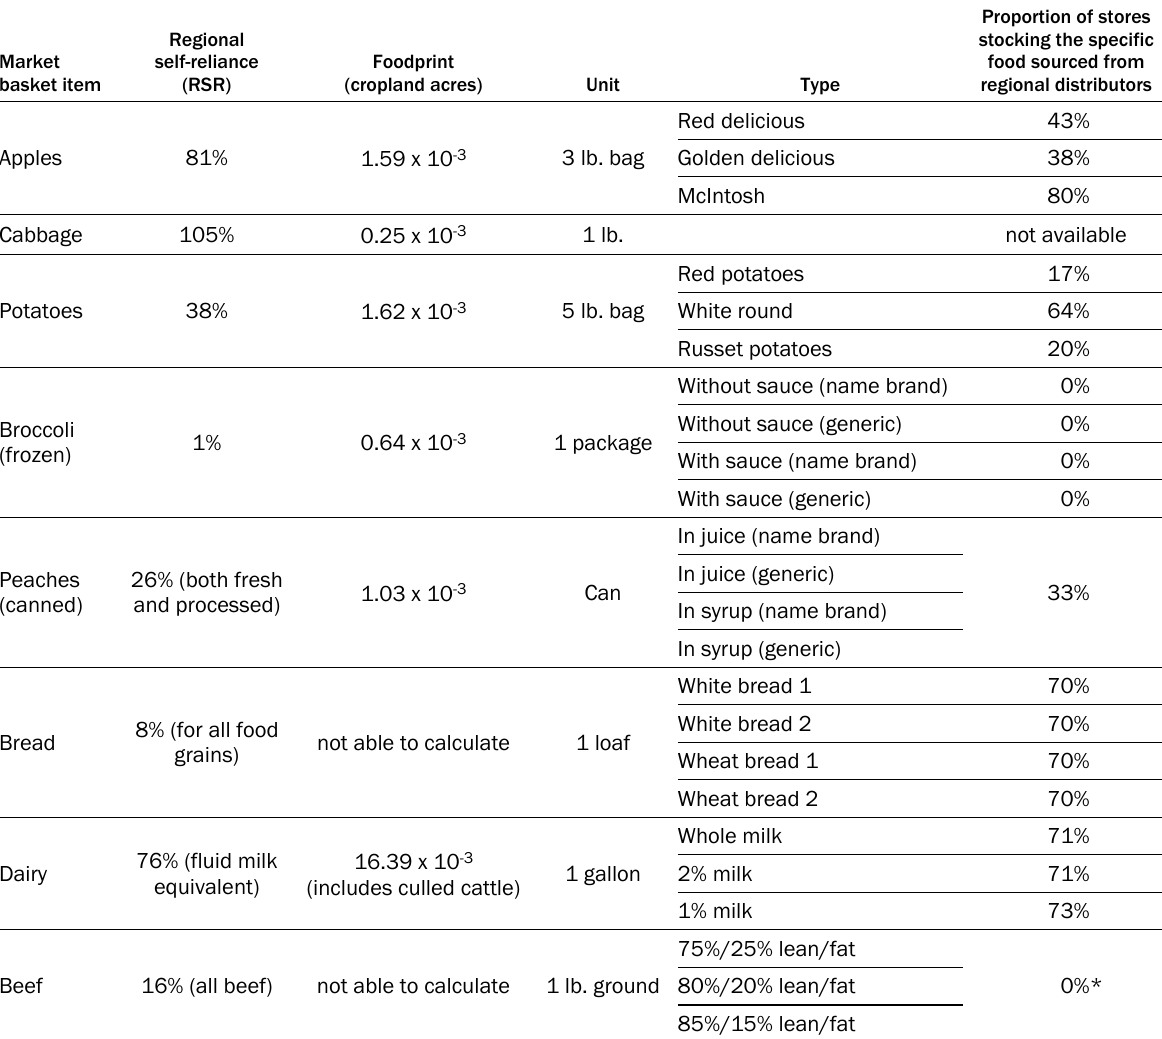
Table 2. Overview of Regional Production, Distribution, and Availability of Market Basket